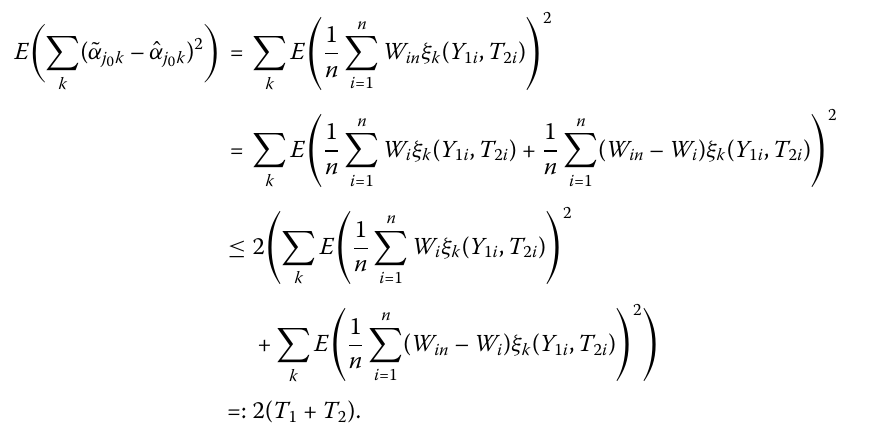
In addition, ˜ α j